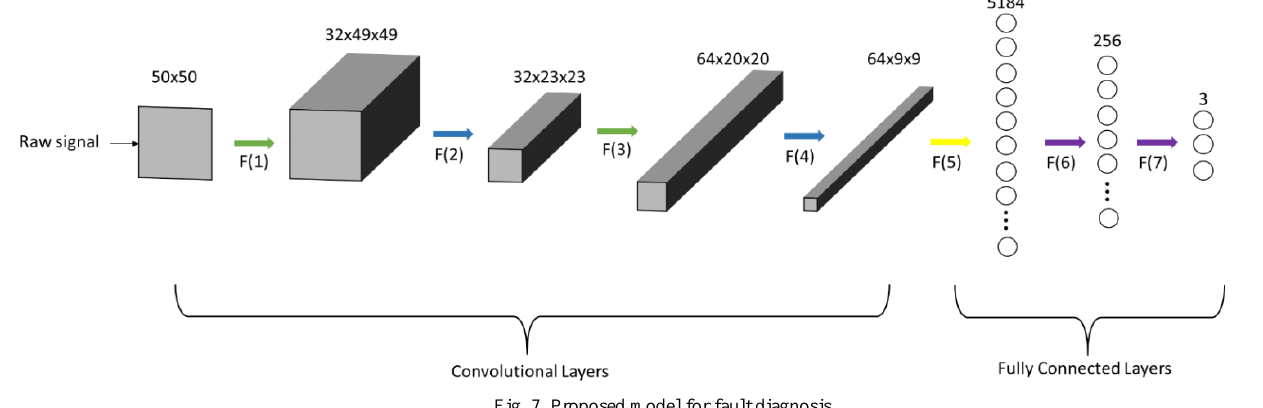
Fig. 7. Proposed model for fault